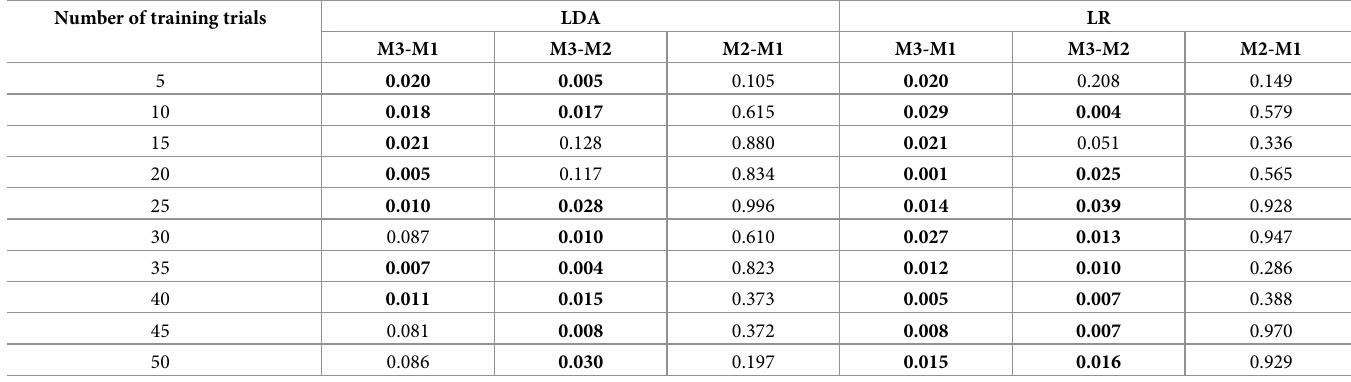
Table 1. p values of paired t-tests at 95% confidence level among the three algorithms Baseline (M1), EMD (M2) and EA-EMD (M3) based on two classifiers LDA and LR for data set 1. Number of training